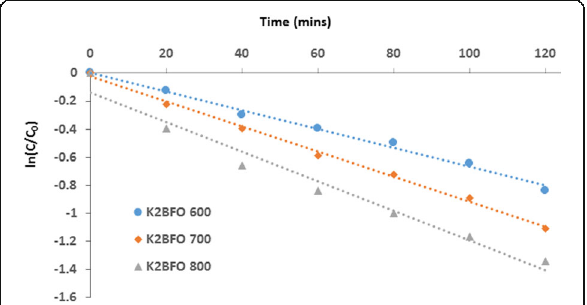
Fig. 6 First-order kinetics of MB photodegradation